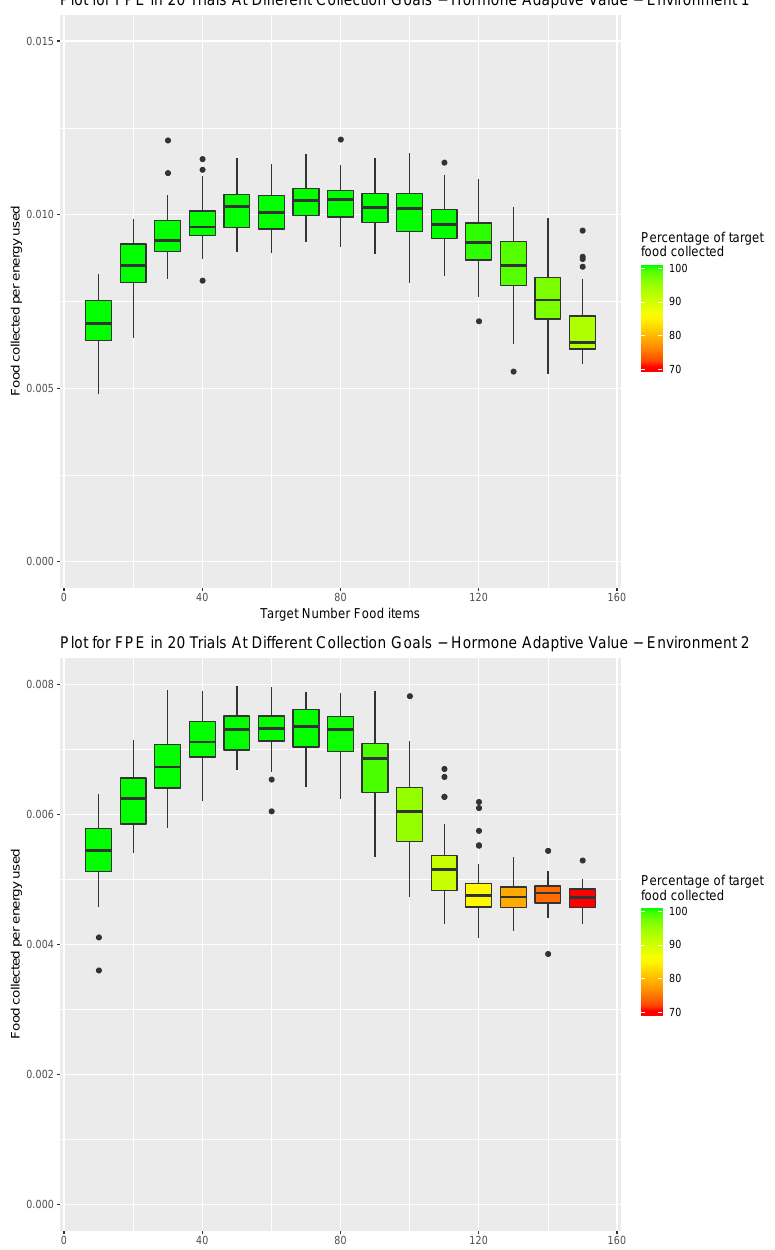
Plot for FPE in 20 Trials At Different Collection Goals − Hormone Adaptive Value − Environment 1